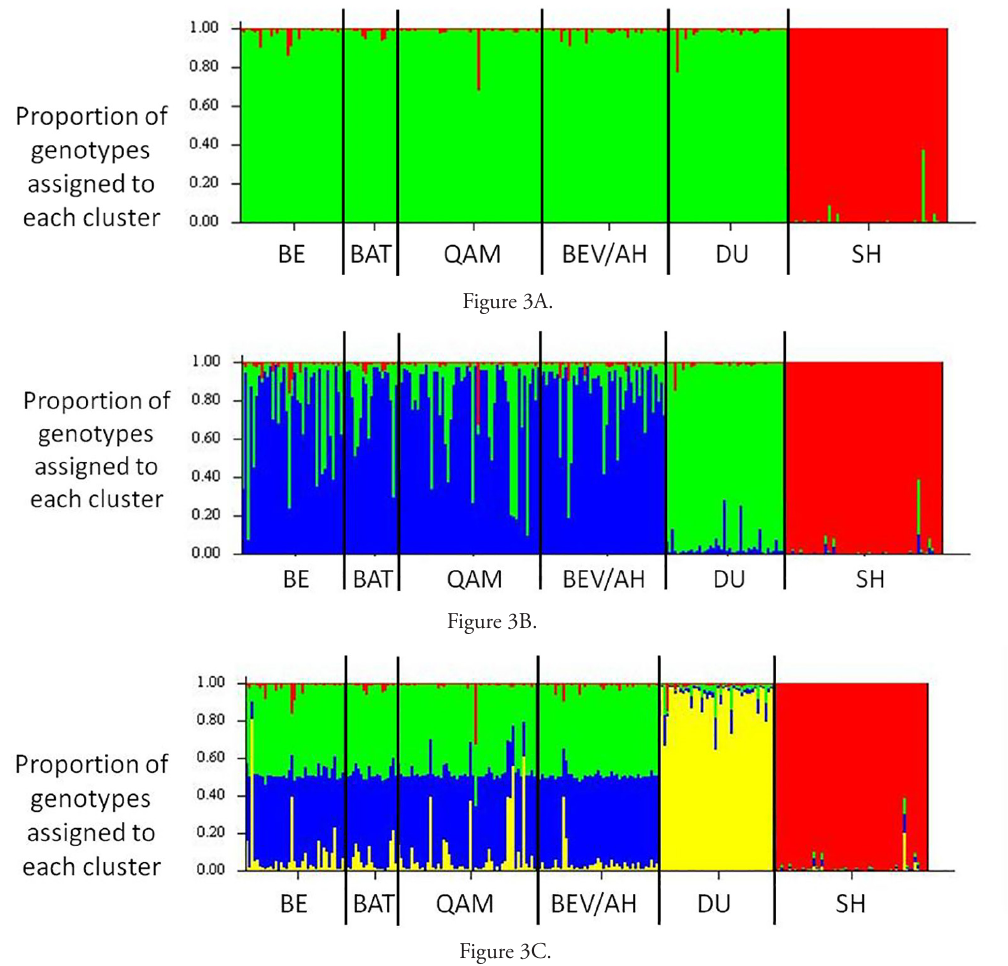
Figure 3. Individual inferred assignment probabilities based on STRUCTURE analysis among the entire set of 256 barren-ground caribou for A) K = 2, B) K = 3, and C) K